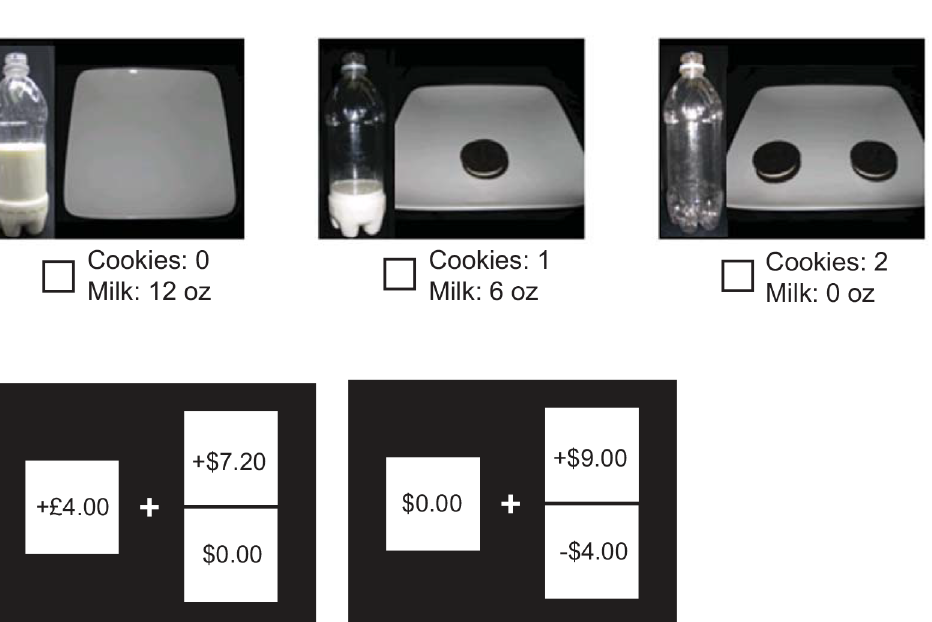
Fig 1. Example trials in the GARP and gambling experiments. (A) Example trial in the GARP experiment. This choice set offers three bundles. The first bundle contains no cookies and 12 ounces of milk. The second bundle contains one cookie and six ounces of milk. The third bundle contains no milk and two cookies. The subject indicates their choice by checking the appropriate box with a computer mouse. ( B) An example gain-only trial (left) and an example mixed gamble trial (right) in the gambling experiment. Subjects indicated their choice by button press. See Methods for more details.